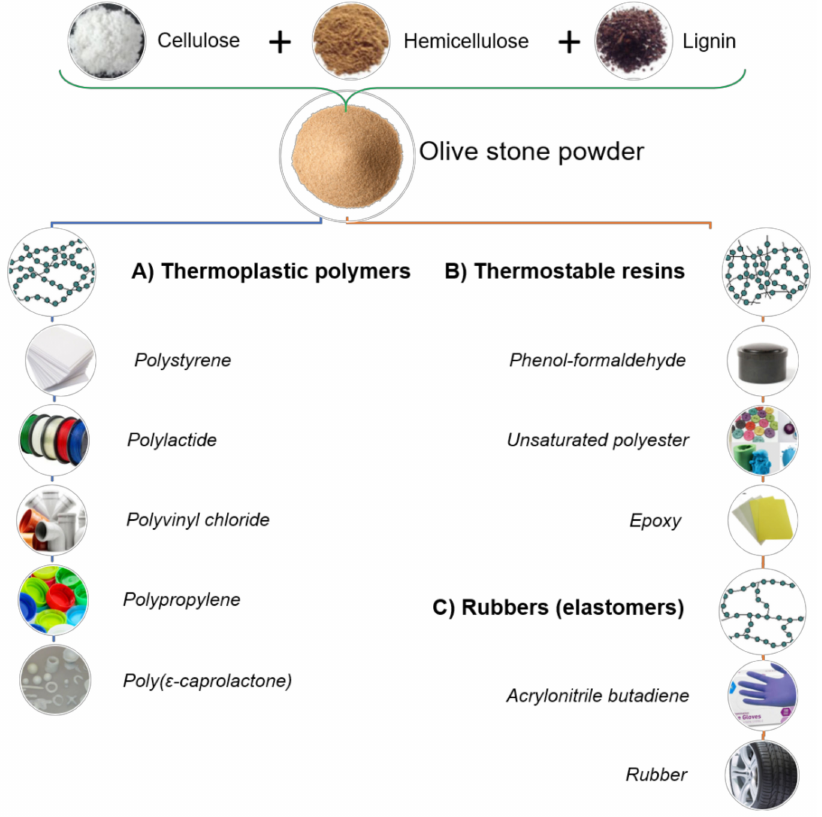
Figure 4. Scheme of the main chemical components present in olive stone powder and main polymer- based composites with olive stones, classified by their crosslinking nature: ( A ) thermoplastic (no cross-linking), ( B ) thermosetting (high degree of cross-linking density), and ( C ) rubbers or elastomers (low cross-link